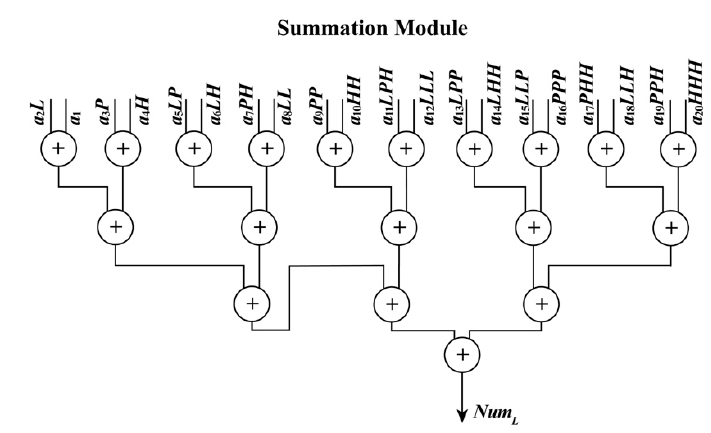
Figure 6. Schematic diagram of summation module.